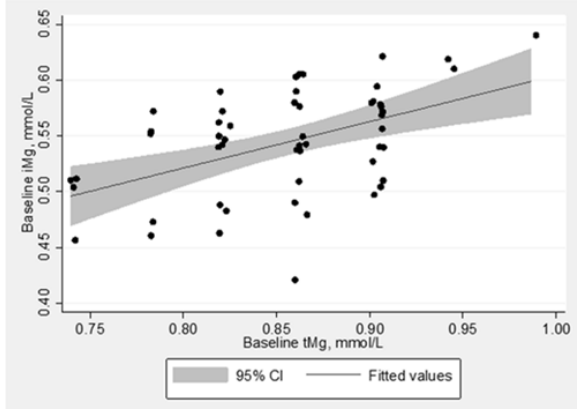
Figure 1. Scatterplot and linear fitted line between ionized and total magnesium at baseline, unadjusted, n = 49. Normalized ionized Mg (iMg) concentration, which is adjusted for blood pH.